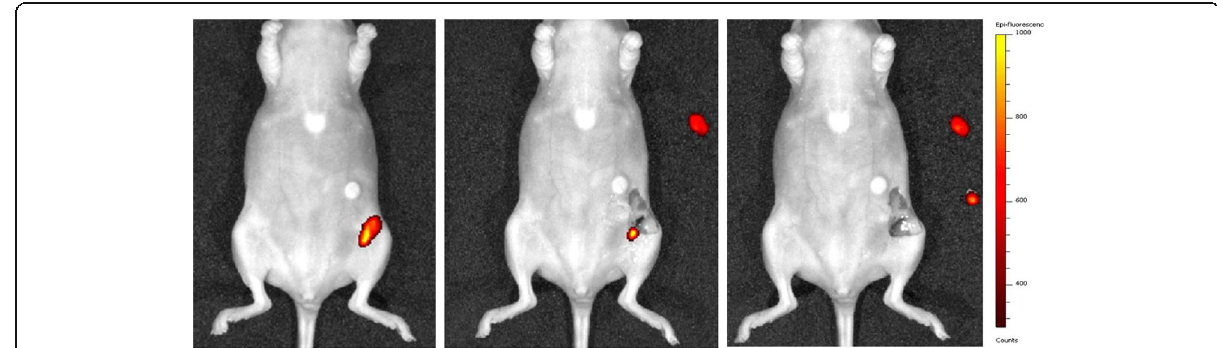
Fig. 5 After injection of 10 μ g [ 111 In]In-DTPA-trastuzumab-IRDye800CW in a mouse bearing a BT474 tumor, fluorescence imaging identified an